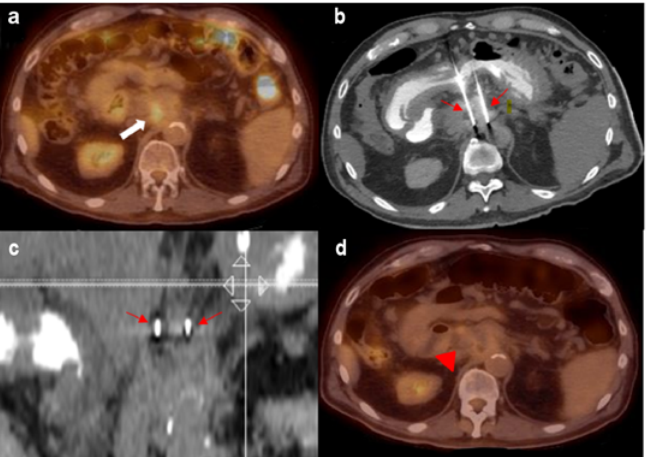
Figure 2. ( a ) FDG ‐ avid recurrent pancreatic mass (white thick arrow). ( b , c ) Two IRE probes in place bracketing the mass (thin red arrows). ( d ) No residual FDG avidity post ‐ treatment (red arrow). bracketing the mass (thin red arrows). ( d ) No residual FDG avidity post-treatment (red